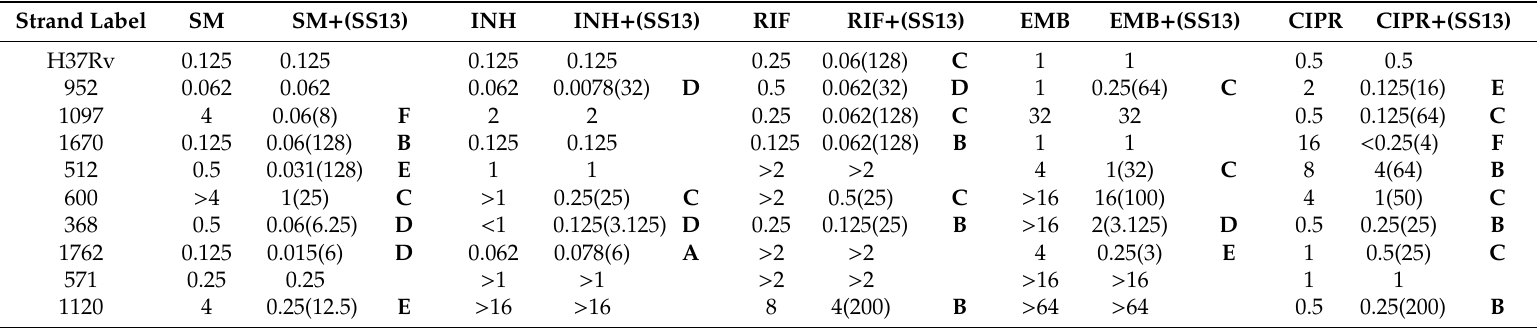
Table 2. REMA test results for 10 M. tuberculosis strains treated with antitubercular drugs alone and in association with SS13 (SS13). MICs reported are given in µ g / mL. In round brackets, the SS13 concentration needed to get the correspondent MIC of each drug in the same cell ( µ g / mL) is shown. Symbols represent the drug activity, which was increased (MIC reduced) x-fold by SS13 e ff ect: A , x = 0.8; B , x = 2; C , x = 4; D , x = 8; E , x = 16; F , x =